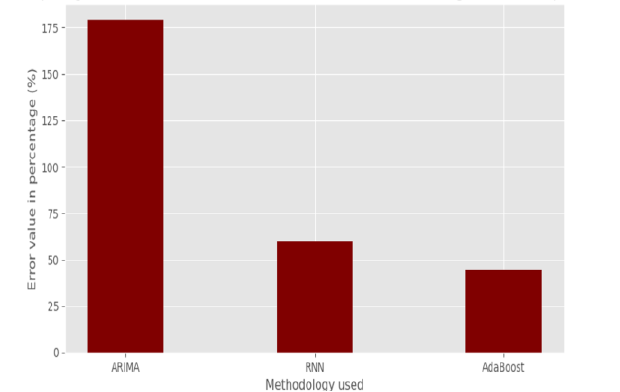
Figure 19. Comparing the Relative error between RNN, AdaBoost, ARIMA for 300 samples, single flow Considering single flow traffic prediction, Fig. 19